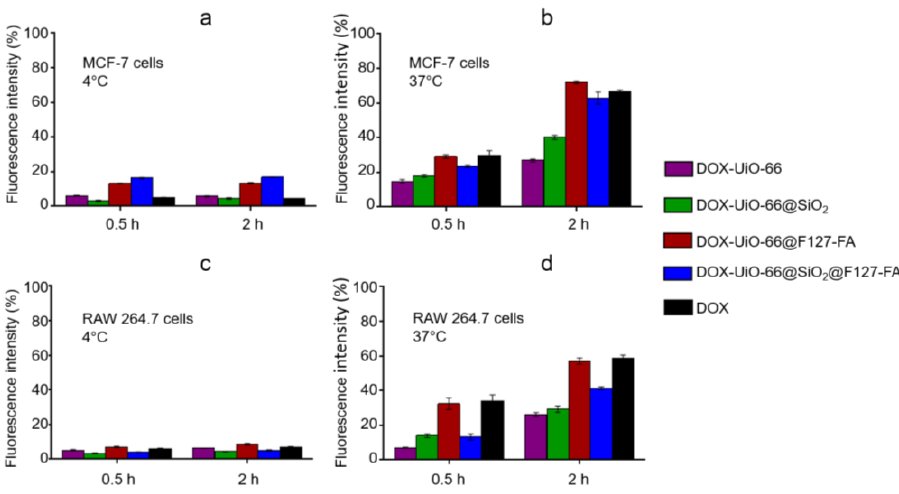
Figure 7. Uptake of the DOX-loaded MOFs and free DOX by MCF-7 cells at ( a ) at 4 °C and ( b ) 37 °C; and for RAW 264.7 w cells ( c ) at 4 °C; ( d ) at 37 °C after 0.5 and 2 h incubation durations. Comparison of cellular uptake in folate-expressing and nonexpressing cells confirms